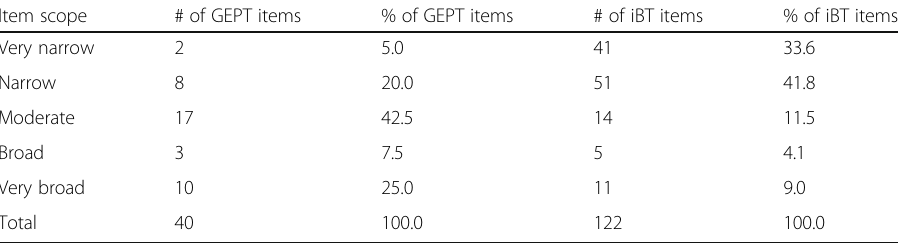
Table 4 Summary of scope of reading items for the GEPT-A and iBT Item